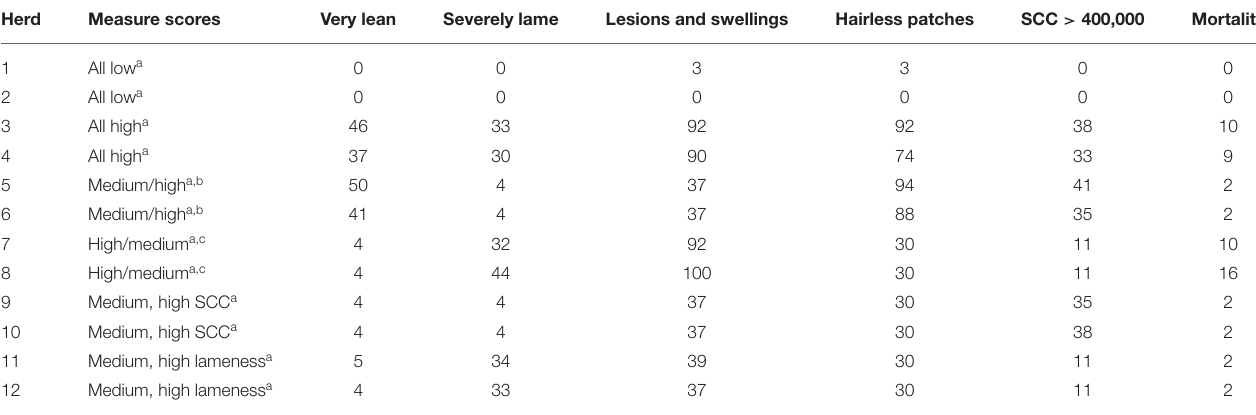
TABLE 1 | Prevalences for the 6 selected dairy cattle welfare measures, for each of the 12 fictitious herds the experts ( n = 14) allocated an integrated index score. Herd Measure scores Very lean Severely lame Lesions and swellings Hairless patches SCC > 400,000